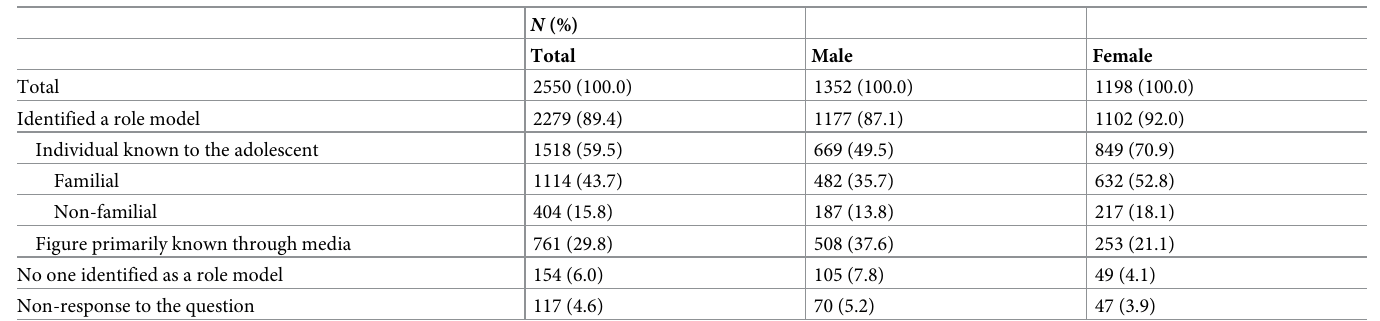
known primarily through media ( N = 761, 29.8%). Of the 2550 adolescents, 154 (6.0%) answered ‘no one’ when asked to identify a role model. No response to the question was given by 117 (4.6%) of the participants. Significantly more male adolescents identified a figure known through the media when compared to females [ χ 2 (1) = 87.84, p < .001]. Of those who reported family members as role models ( N = 1114), 976 (87.6%) identified their parents. Non-familial known individuals, indicated as role models by 404 of the adoles- cents, included friends ( N = 184, 45.5%) and teachers ( N = 183, 45.3%). A qualitative review of responses identifying figures known via media as role models ( N = 761) yielded 14 sub-categories based on occupational groups. Types of figure role models are presented in Table 2. Males were more likely to identify a sports player as a role model ( N = 208, 40.9%), whereas females were more likely to identify a historical figure who was devoted to humanity ( N = 68, 26.9%) or an artist ( N = 51, 20.2%). Of the 2550 adolescents, 2539 responded to the question regarding hopefulness ( M = 7.3, SD = 2.1). Level of hopefulness of future expectations according to role model is summarised in Table 3. Hopefulness was significantly higher in adolescents who identified a role model than those who identified no role model.